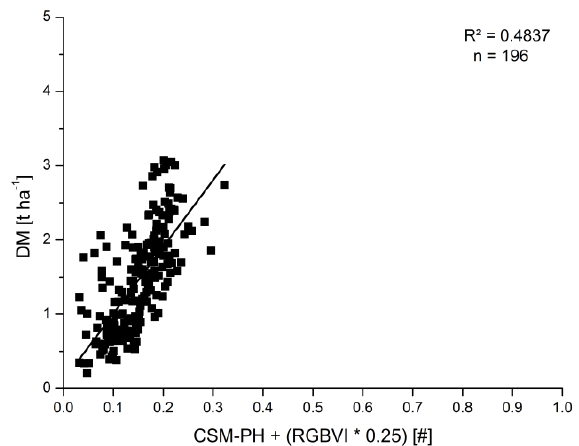
Figure 8a. Grass I from photos (CSM-PH aggregated with 25 % of each RGBVI value) versus dry matter (DM), G 2 & 3